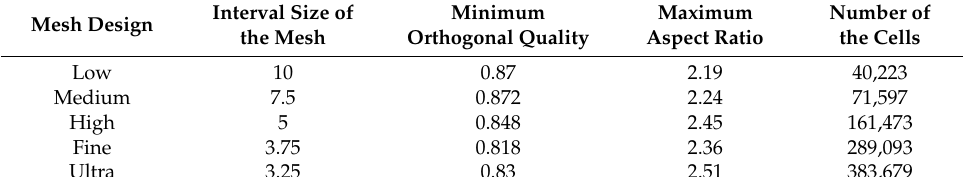
Table 3. Meshing details of one loop micromixer with 0% of expansion.